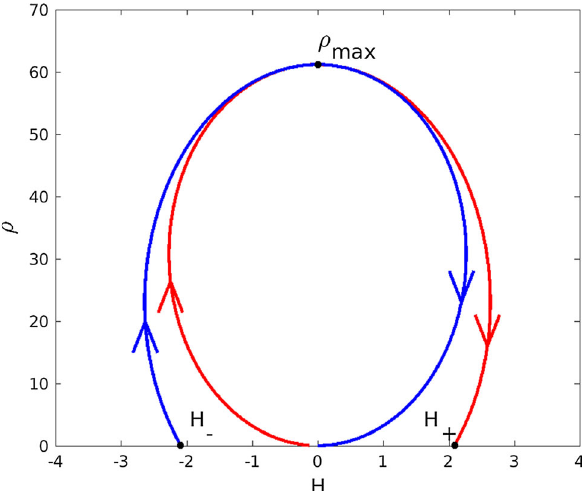
Fig. 2 Curve depicted by the Friedmann equation in the Dapor– Liegener model of LQC, and its dynamics for either a non-phantom fluid or field. Blue: branch with β > 0. Red: branch with β <